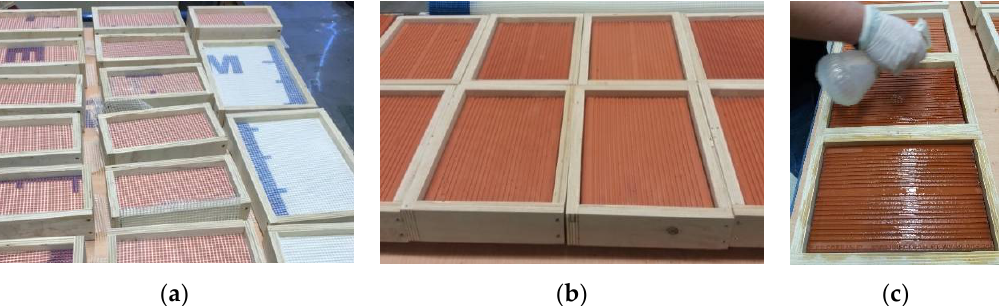
Figure 3. Substrates preparation: with the fibreglass mesh ( a ); without the fibreglass mesh ( b ); wetting the application surface of the hollow ceramic bricks substrates ( c ).